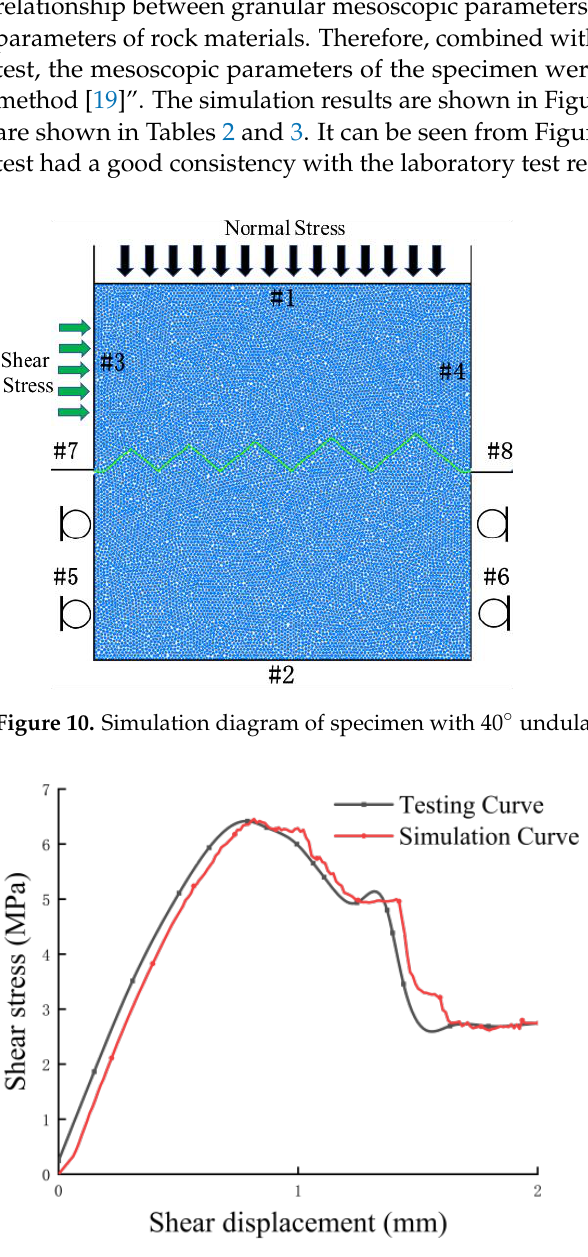
Figure 11. Laboratory direct shear test and PFC simulation curve. Table 2. Mesoscopic parameters of particle and parallel bonding models.